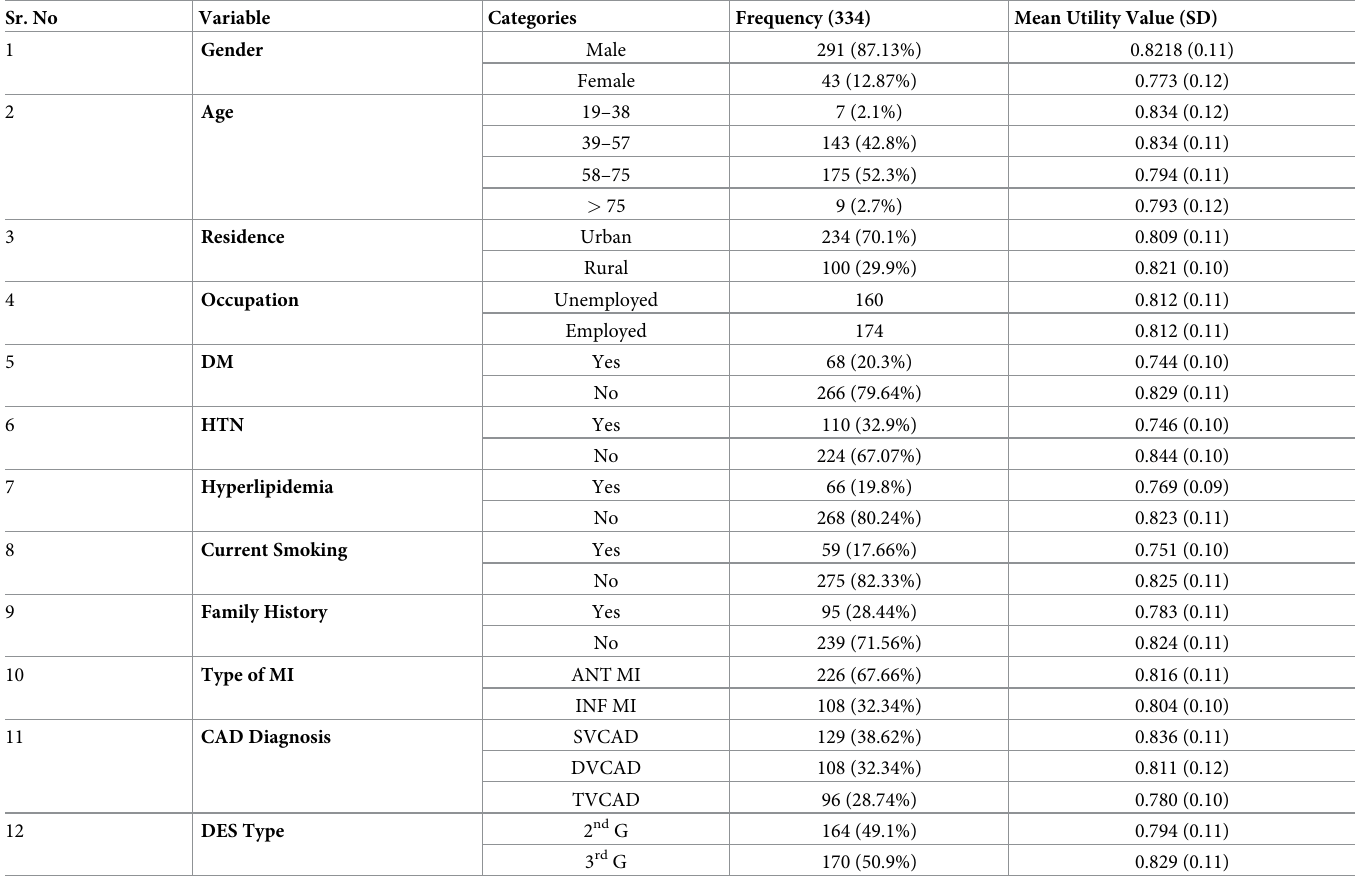
Table 1. Distribution of utility values with demographic, angiographic variables and risk factors. Sr.